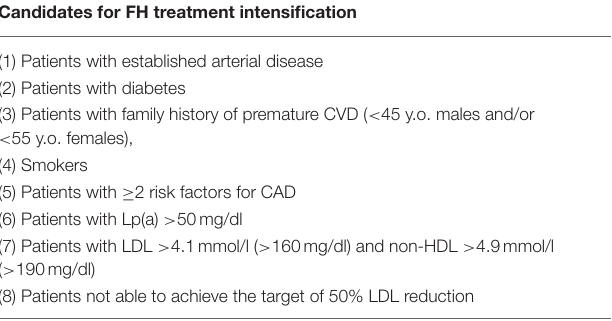
TABLE 7 | Candidates for familial hypercholesterolemia treatment intensification. Candidates for FH treatment intensification